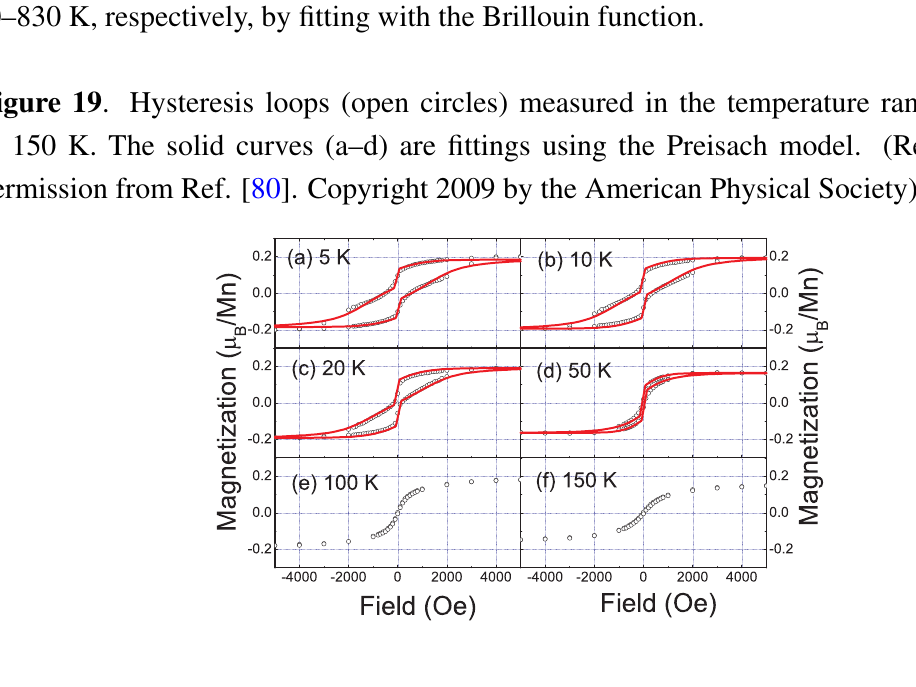
Figure 20 . (a) M–H curves at 300 K for Mn implanted Si (S1: 0.4% Mn, and S2: 1.8% Mn). The inset shows their ZFC (open circles)-FC (filled circles) curves from 5 to 390 K under an applied field of 100 Oe. (b) M-T curves from 410 to 800 K for S1 and S2 samples under an applied field of 1.5 kOe. The red dashed lines are fits to M (Reprinted with permission from Ref. [69]. Copyright 2008, American Institute of